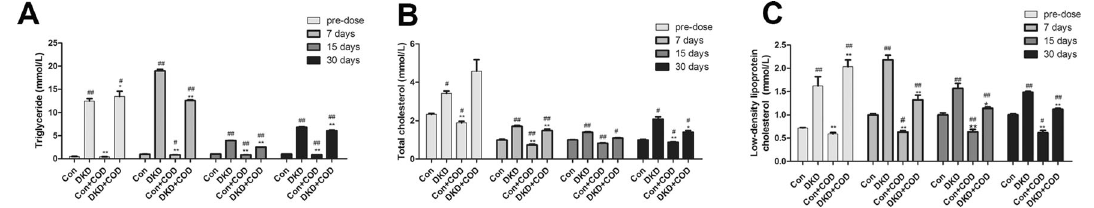
Fig. 5 Effect of COD on lipid metabolism in DKD rats. Serum levels of triglyceride ( a ), total cholesterol ( b ), and low-density lipoprotein cholesterol ( c ) were measured on days 7, 15, and 30 after the COD